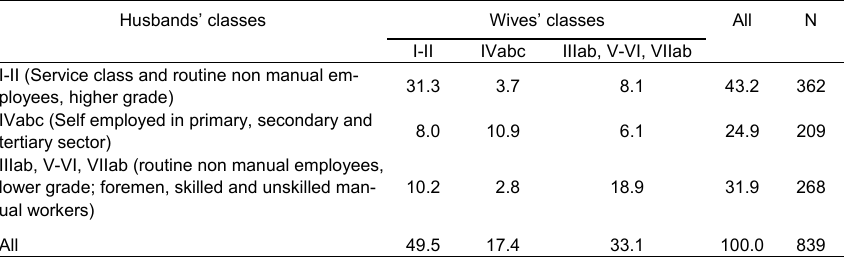
Tab. 2 Homo/heterogamy in dual-earner couples aged 18-65. Occupational classes of husbands and wives. Italy 2001. Cell percentages Husbands’